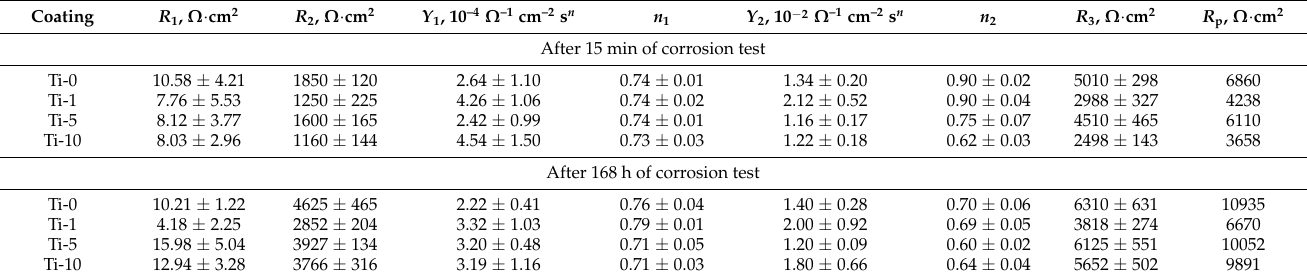
Table 4. Fitting data and calculated polarization resistance ( R p ) extracted from EIS measurements.